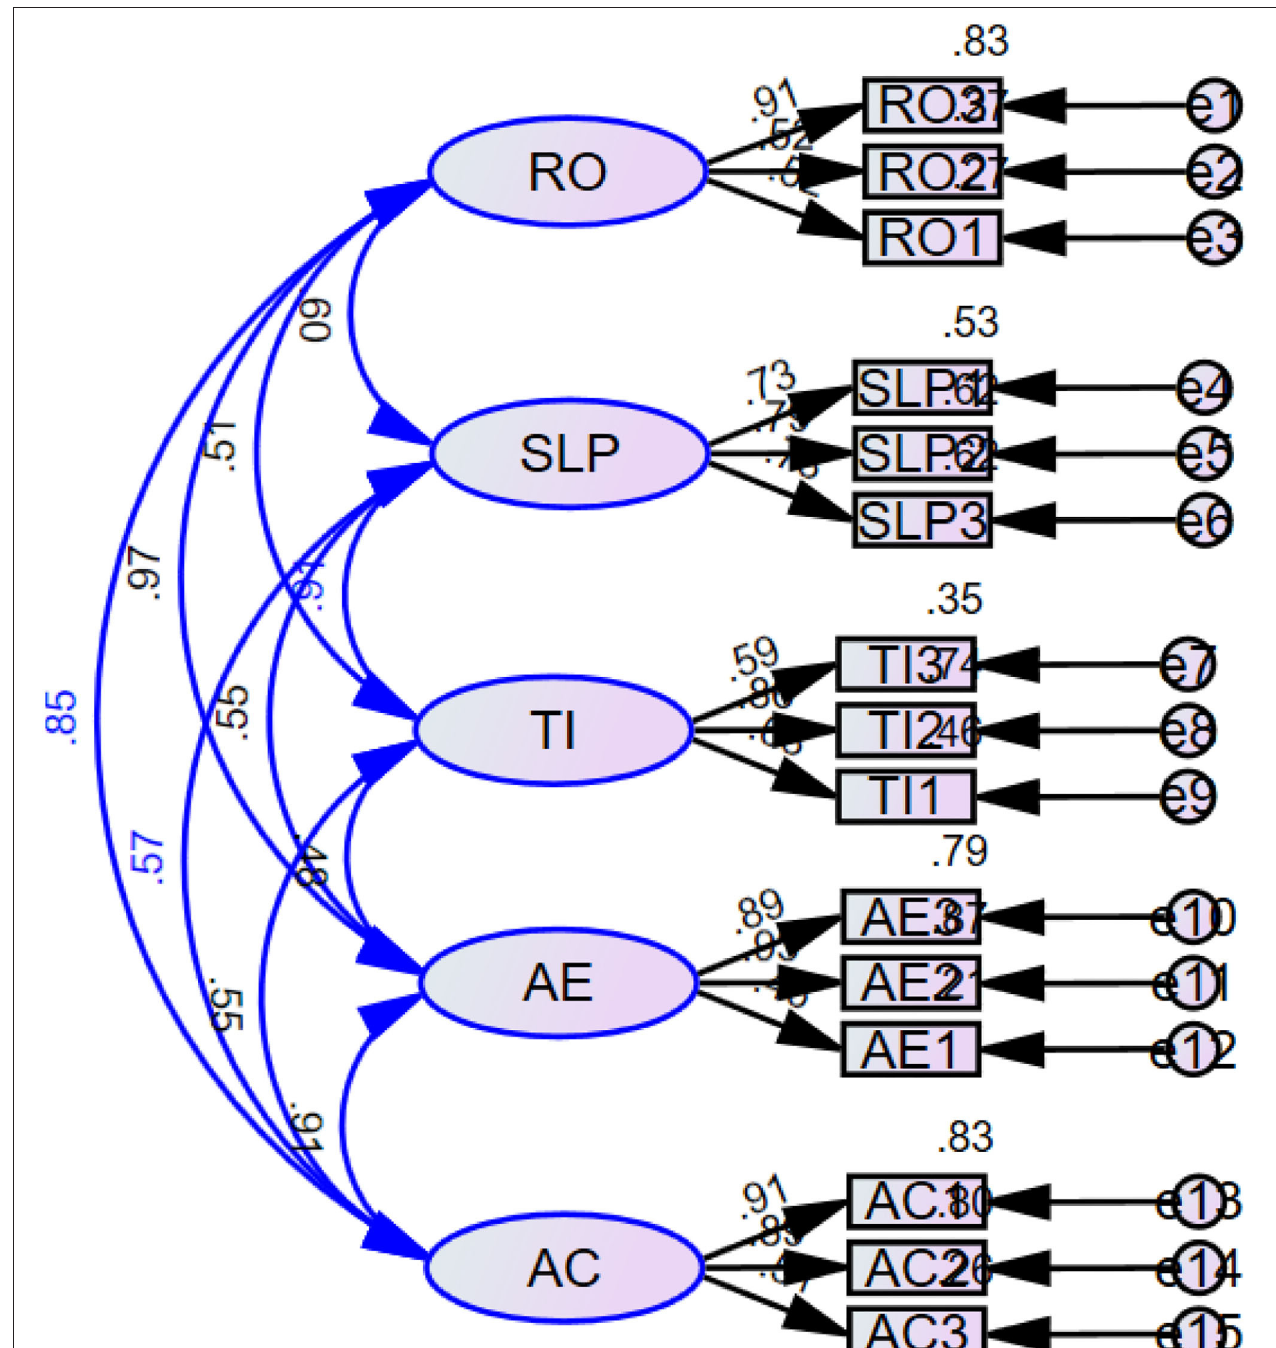
FIGURE 2 | Measurement